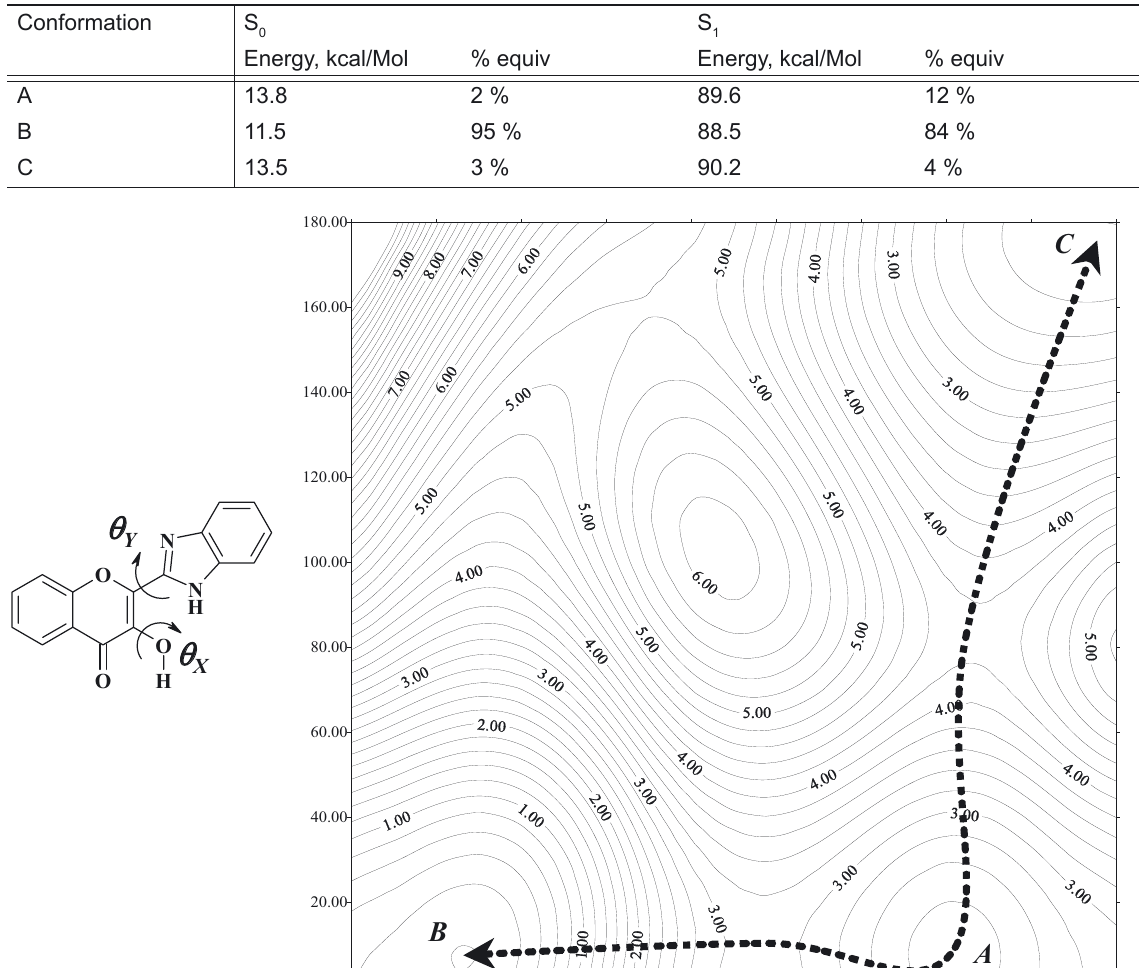
) and the benzimidazole ring ( θ